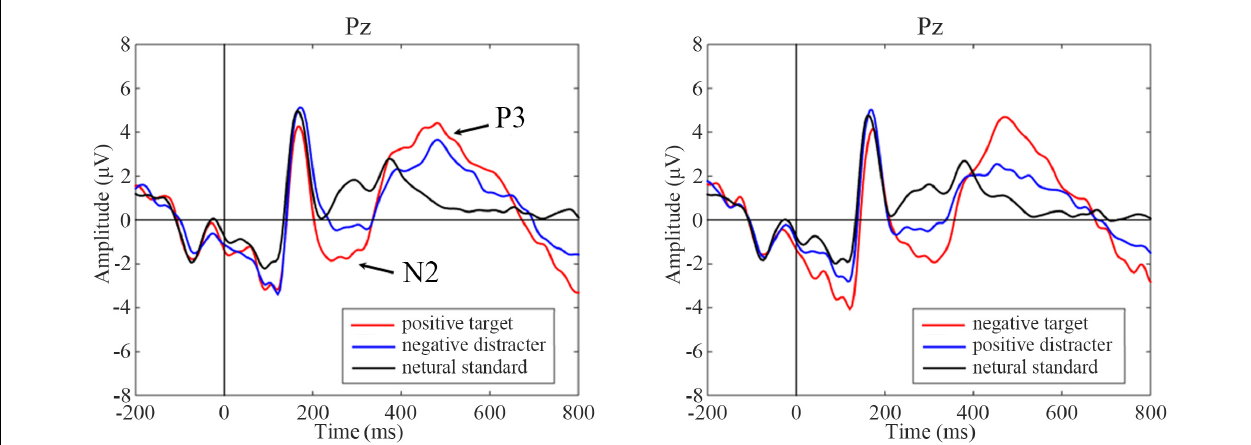
FIGURE 4 | Event-related potentials (ERP) waves on different task conditions at pre-treatment test in the sham group as an illustration. Black vertical lines indicate the initial time, and P3 and N2 components are marked with arrows. Positive target task shows on the left and negative target task on the right. For ERP plots, the y -axis displays amplitude ( µ V) and the x-axis displays time (ms).